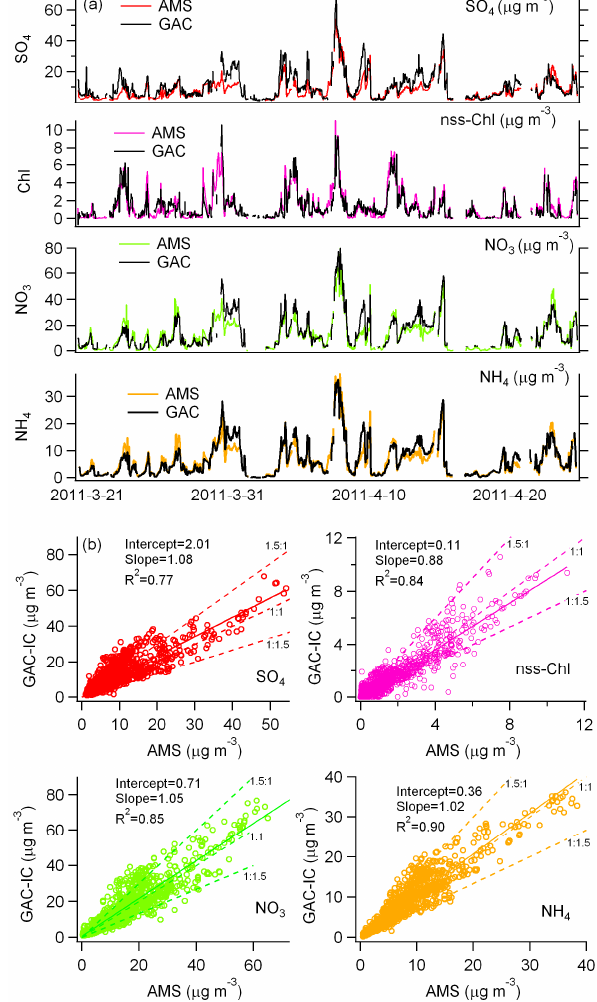
Fig.13. Inter-comparisons between the GAC-IC system and the AMS. We use 30-min Fig. 13. Inter-comparisons between the GAC-IC system and the average data for the inter-comparisons. The solid lines represent the regression lines. AMS. We use 30-min average data for the inter-comparisons. The The dashed lines indicate 1.5:1, 1:1 and 1:1.5 correspondence lines. solid lines represent the regression lines. The dashed lines indicate 1.5:1, 1:1 and 1:1.5 correspondence 43